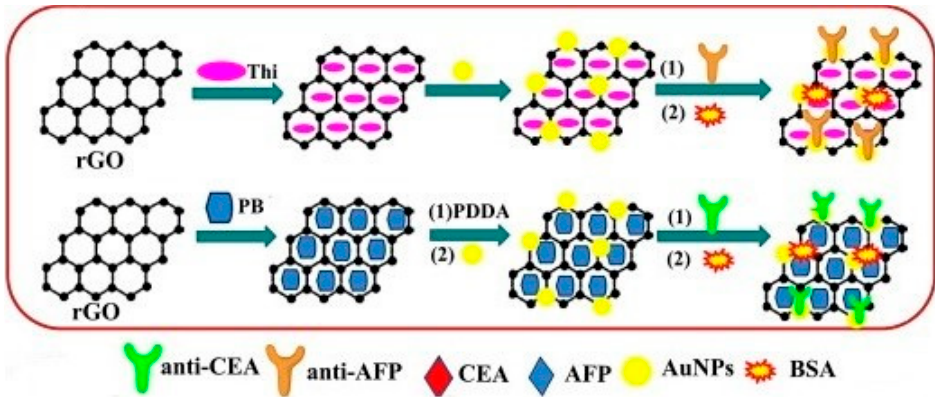
Figure 5. Preparation process of immunosensing probes. In brief, reduced GO was first treated with Thi/Pb for their electrostatic binding, which was then utilized for physical adsorption of pre-synthesized AuNPs onto Thi/rGO or PDDA modified PB/rGO. The bound AuNPs were then utilized for physical adsorption of desired antibodies. Reproduced with permission from [36].